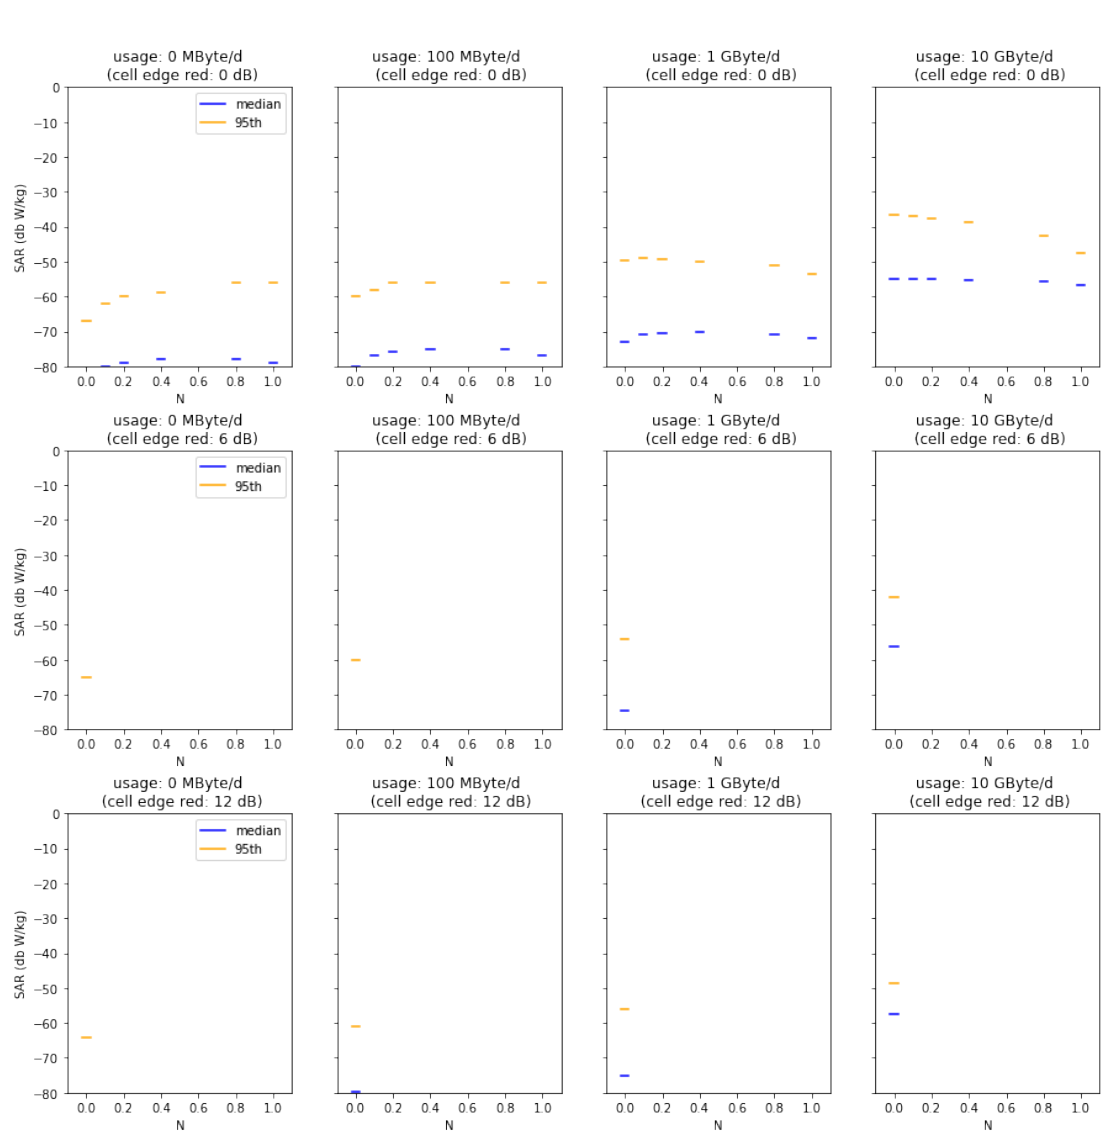
Figure A5. Median and 95th percentiles for varied usage, indoor coverage factor N , and cell size reductions in the urban-micro cell